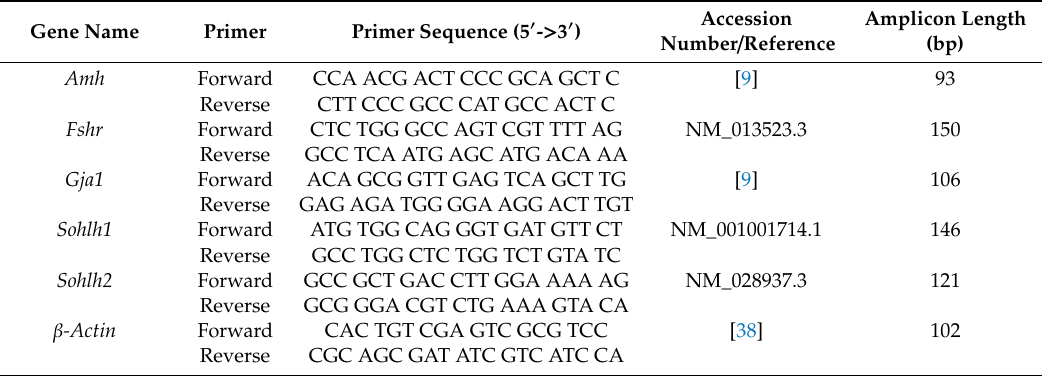
Table 2. Primers used for